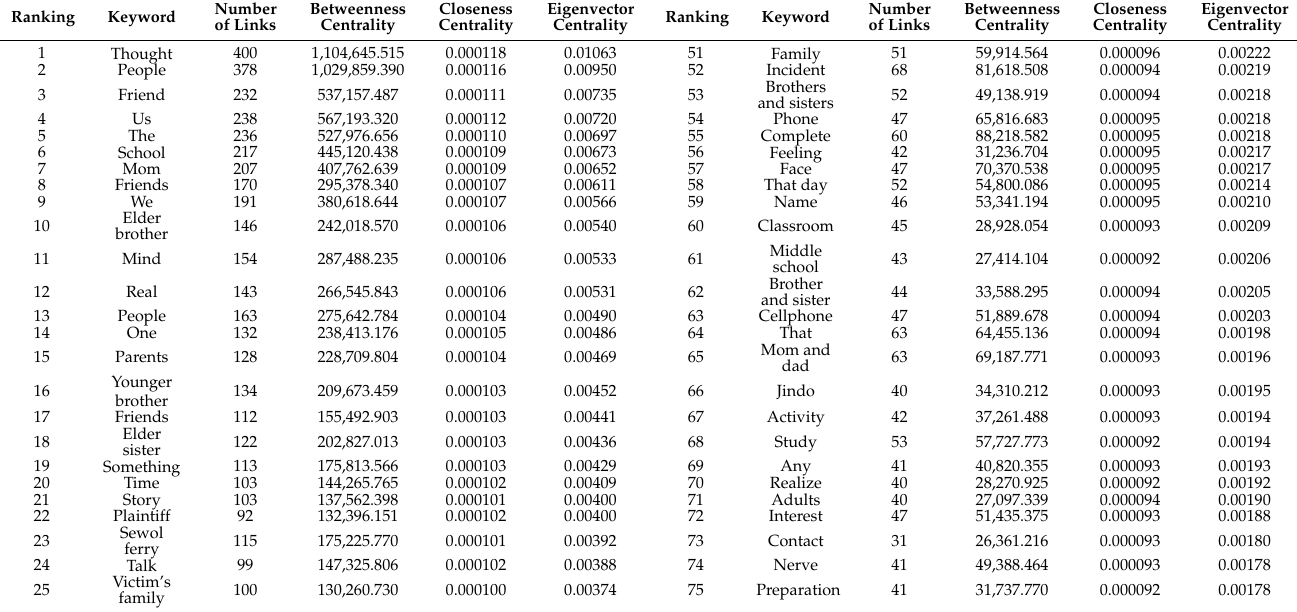
Table 4. Eigenvector Centrality Survivor Top 100